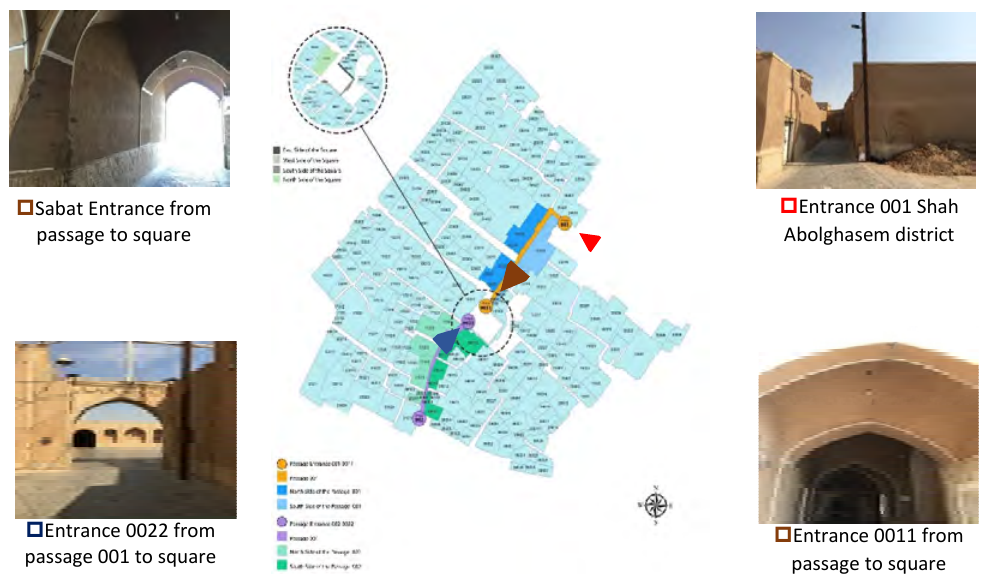
Fig. 3: Location of the square, passages, and main entrances of Shah Abolghasem district of Yazd